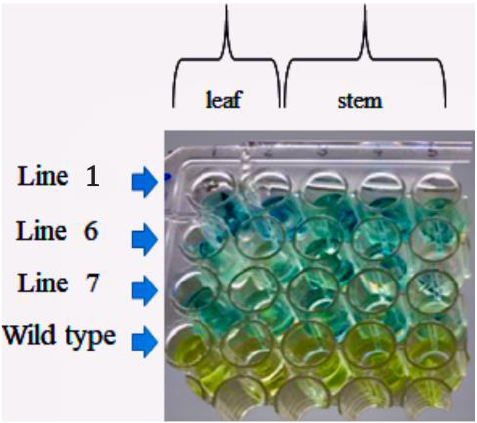
Figure 6. In vivo GUS assay on leaf and stem explants of A. oleracea transgenic and wild type re- generated plants.